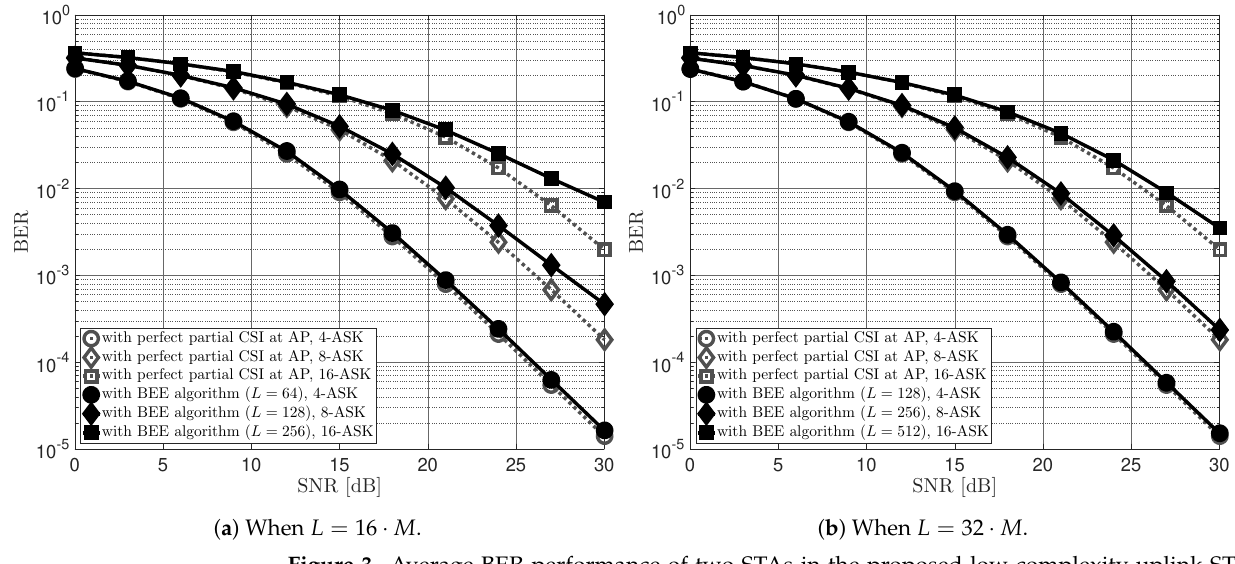
Figure 3. Average BER performance of two STAs in the proposed low-complexity uplink STLC- NOMA system employing the BEE algorithm at the AP with respect to the frame length.